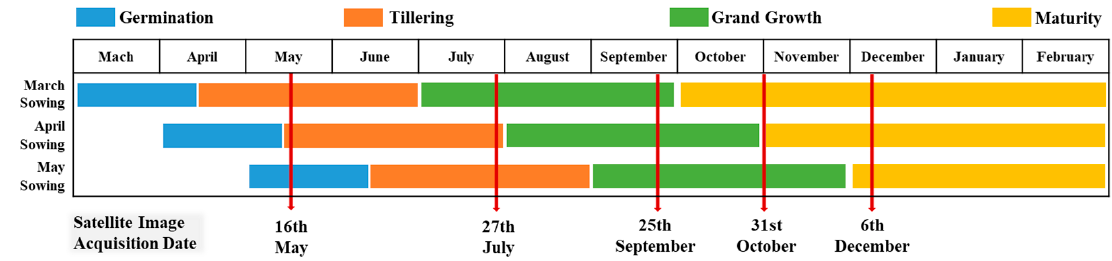
Figure 2. Satellite image acquisition.